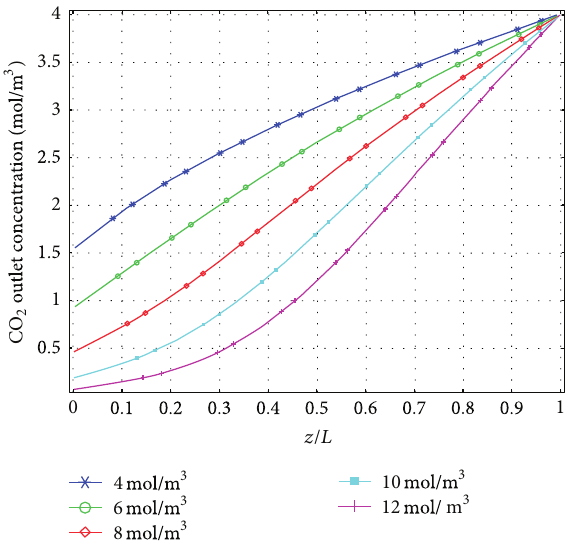
= Figure 7: Removal percentage under different gas concentration. MEA = 0.15 mm, 𝑟 = 0.2 mm, 𝑟 = 0.3 mm, 𝐿 = 900 mm, V 𝑟 1 2 3 0.2 m s −1 , and V = 0.5 ms −1 MEA